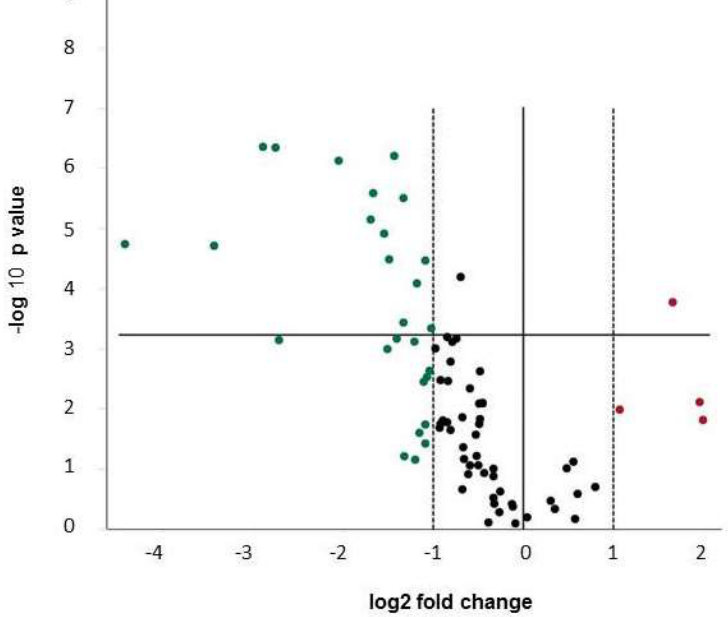
Figure 3. Volcano Plot for changes of gene expression in MG63 cells after 24 h incubation with CoCl 2 vs. unstimulated control. Expression data are normalized vs. glyceraldehyde 3-phosphate dehydrogenase (GAPDH). The statistical significance is plotted versus fold-change on the y - and x -axes, respectively. The horizontal line represents the significance level ( p = 0.0006). Up-regulated genes are depicted in red, down-regulated genes in green and genes regulated by less than factor 2 in black. Low abundant transcripts are included. Data are summarized from four independent experiments.